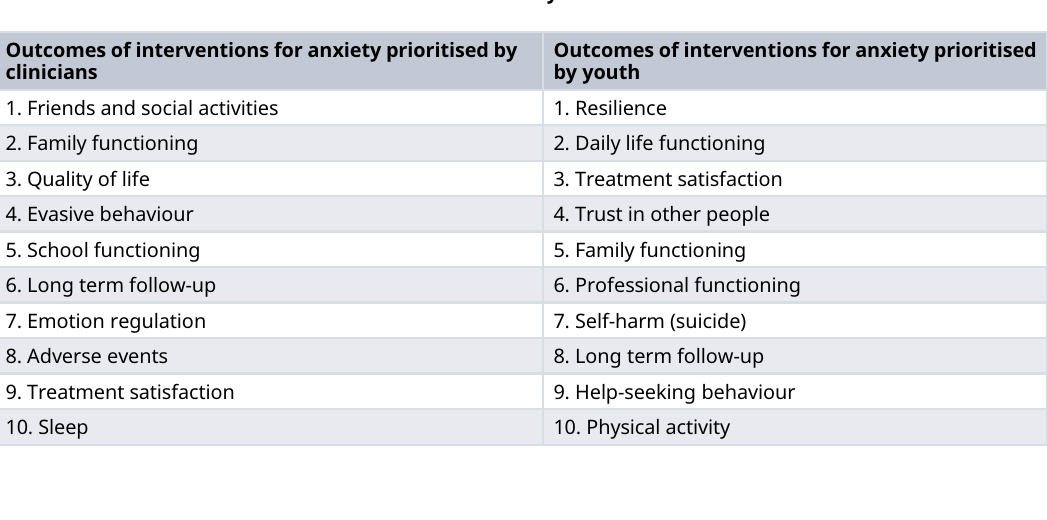
Table 5. Prioritised treatments for